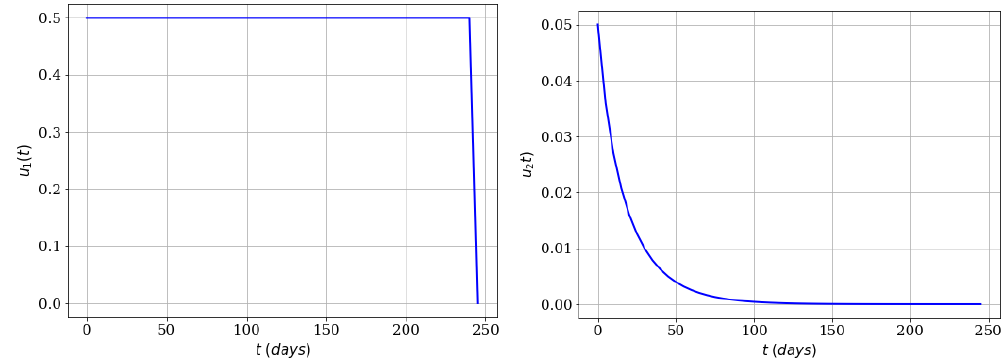
Figure 6. Numerical simulation using both infected subpopulations in the functional ( κ 1 = 0.1, κ 2 = 0.01, u 1 max = 0.5).